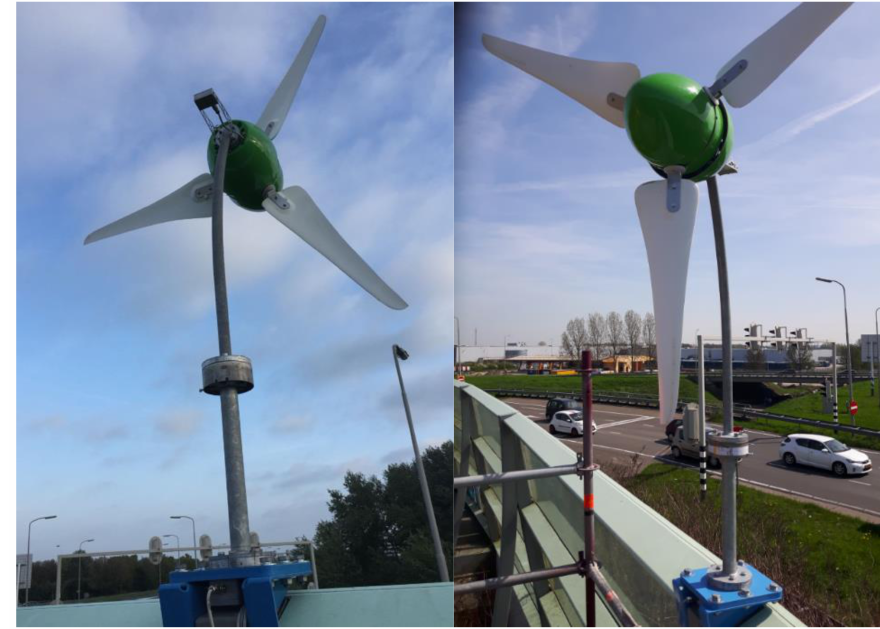
Figure 1. Micro wind turbine integrated on top of the noise